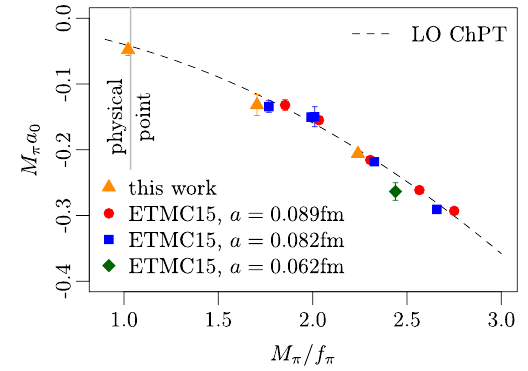
Fig. 1 I = 2 scattering length M π a 0 as a function of M π / f π compar- ing the N f = 2 + 1 + 1 ETMC twisted mass results [3] with this work. The dashed line represents the leading order ChPT prediction